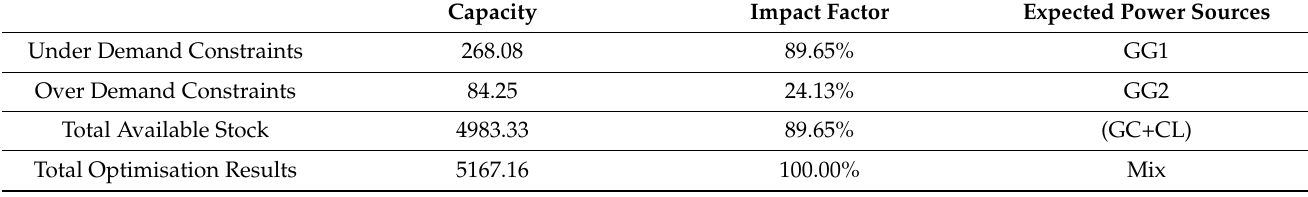
Table 10. Summarising Losses Cost Simulation and Optimisation.